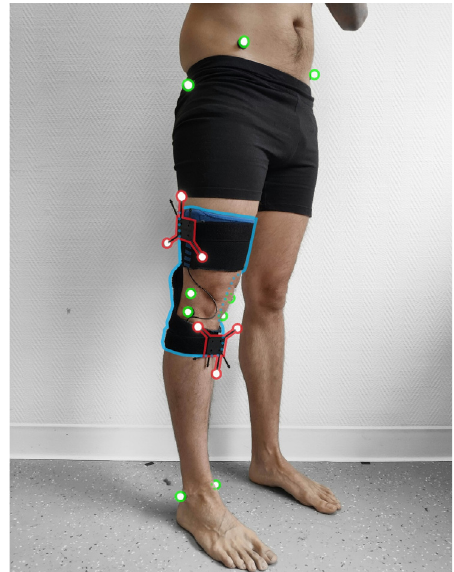
Figure 1. The instrumented knee brace is highlighted in blue, the anatomical reflective markers used for bone calibration are in green, and clusters with reflective markers used for knee kinematics are in red. Anatomical reflective markers were fixed onto the medial malleolus (MM), the lateral malleolus (LM), the medial and lateral epicondyle of the tibia (MT, LT), the medial and lateral epicondyle of the femur (MF, LF), the greater trochanter, the right and left anterior superior iliac spine, and the right and left posterior superior iliac spine.